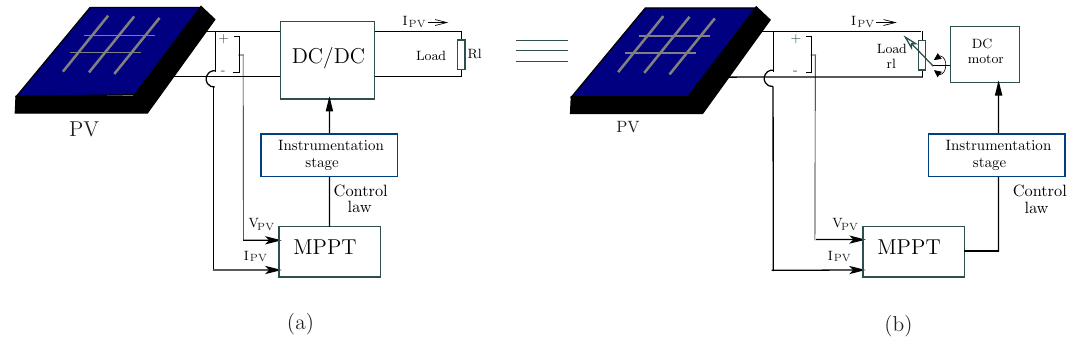
Figure 3. Two equivalent block diagrams of a PV